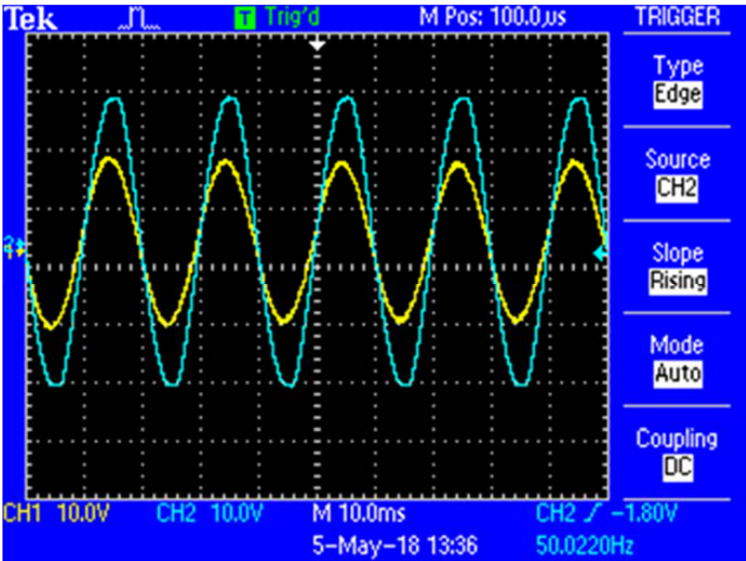
Figure 7. PMSM stator’s voltage and current oscillograms with 302 V applied to the PMSM input. From Figure 7, it is visible that blue PMSM voltage curve corresponded by period to the yellow